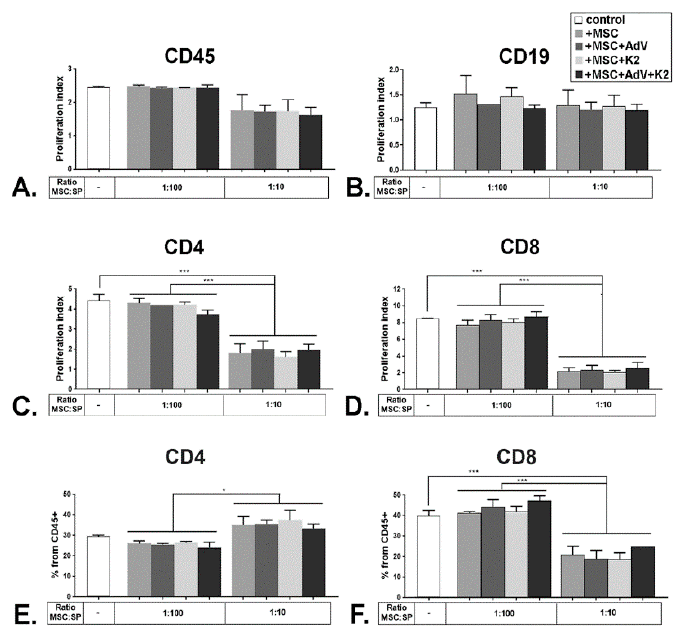
Figure 8. Immunomodulatory properties of MSC are not affected upon exposure to KTS. Whole splenocytes were labeled with carboxy-fluorescein succinimidyl ester (CFSE) and cultured in the presence of CD3/CD28 stimulation beads for 72 h alone (control), or together with naïve MSC (+MSC), transduced MSC (+MSC + AdV), K2TS-treated MSC (+MSC + K2) and transduced MSC in the presence of K2TS (+MSC + AdV + K2), in different ratios, as indicated. At the end of the incubation time, the proliferation index of the populations of splenocytes positive for CD45 ( A ), CD19 ( B ), CD4 ( C ), and CD8 ( D ) was calculated. The percentage of CD4+ ( E ) and CD8+ ( F ) cells from the CD45 positive splenocytes were determined and represented. * corresponds to a p -value < 0.05, and *** for p < 0.0005, by